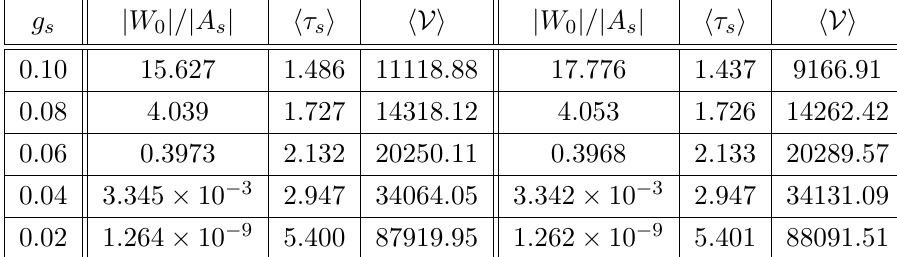
Table 1 . Five choices of the underlying parameters which lead to a Minkowski vacuum. The values on the left have been obtained by using the leading order potential while the values listed on the right have been obtained using the full scalar potential. Notice that the leading order potential produces the global minimum with quite good accuracy for small string